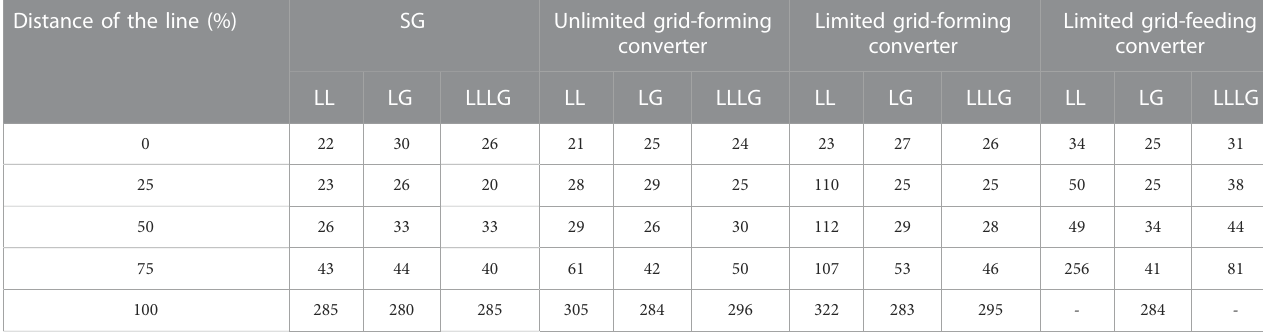
TABLE 4 Average tripping time for different fault distances for different faults and devices (Unit: ms). Distance of the line